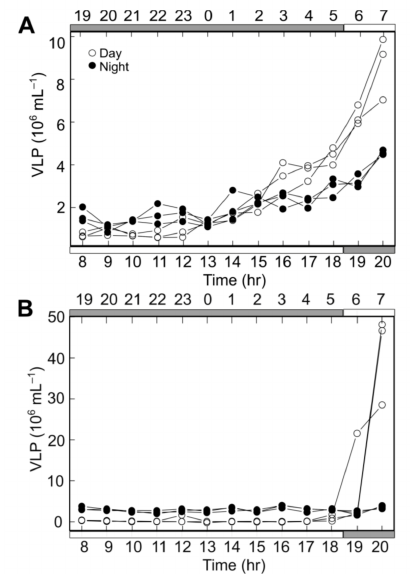
Figure A1. Temporal variation in density of virus-like particles (VLP) in three replicates of diluted incubation. Daytime incubations from 8:00–20:00 (open circles and lower axis) and nighttime incuba- tions from 19:00–7:00 the next morning (filled circles and higher axis). Experiments were